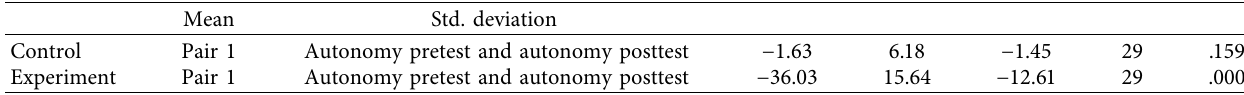
Table 5: Paired-sample test:paired differences.